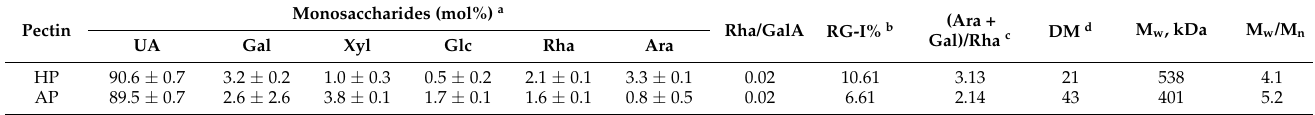
Table 9. Chemical characteristics of AP and